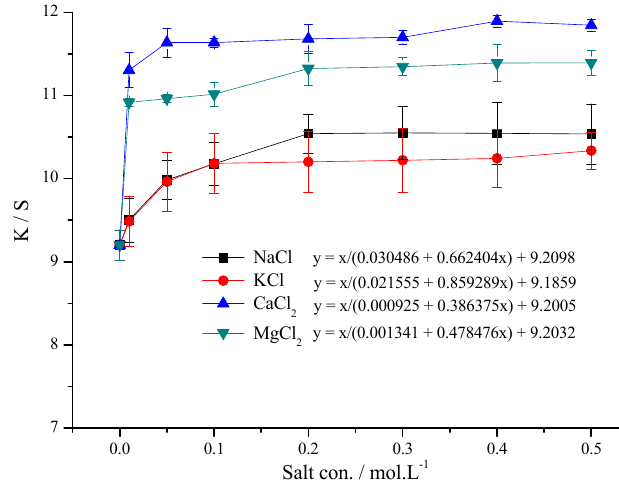
Figure 3. E ff ect of salt concentration on the K / S value of inkjet Figure 3. Effect of salt concentration on the K/S value of inkjet printing.